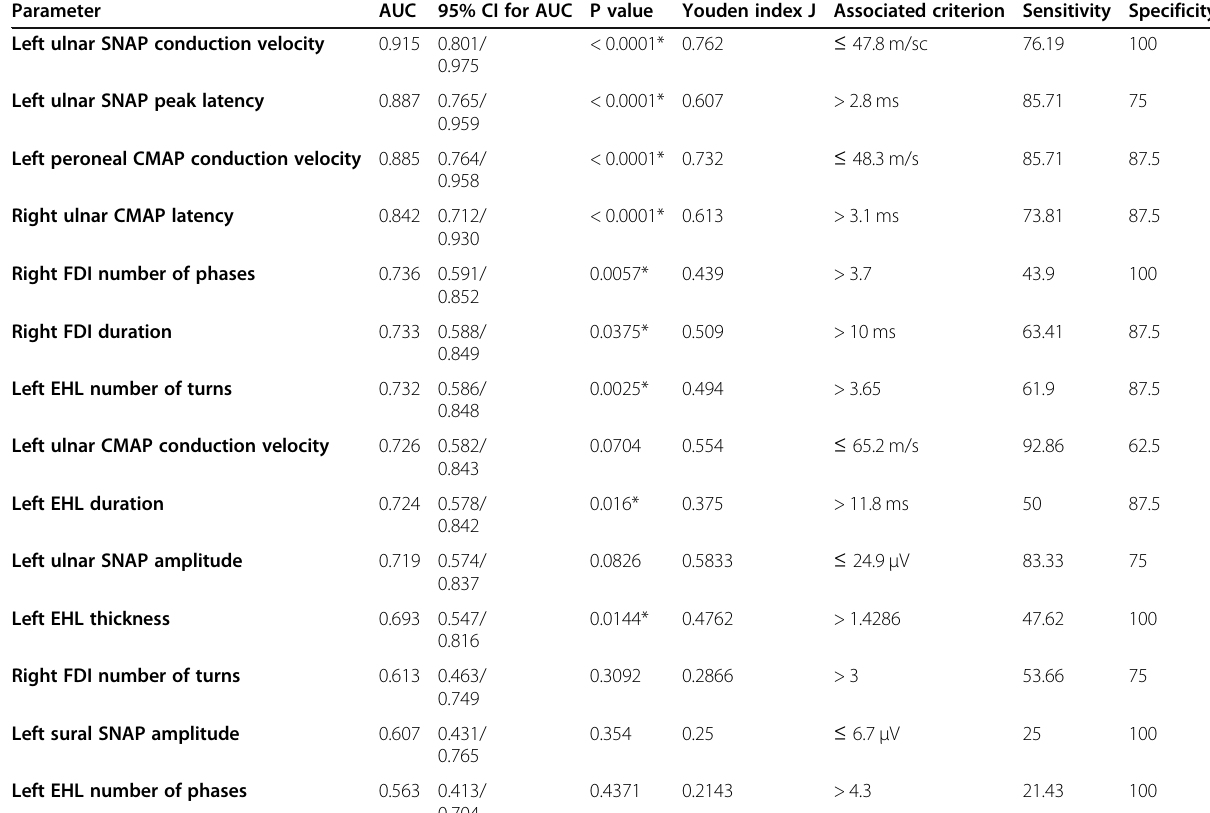
Table 5 Diagnostic accuracy of different electrodiagnostic parameters using ROC curve analysis Parameter AUC 95% CI for AUC P value Youden index J Associated criterion Sensitivity